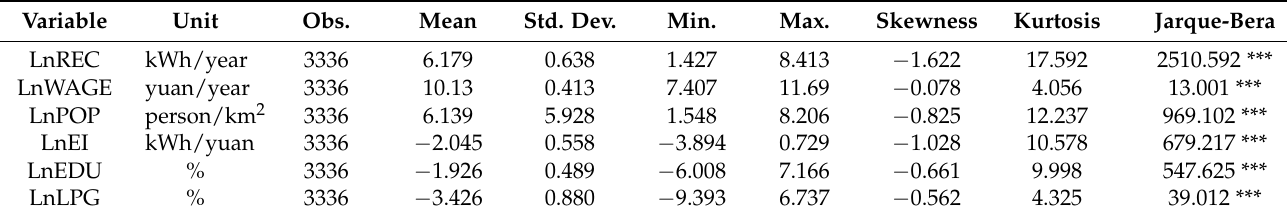
Table 2. Descriptive statistics of variables.